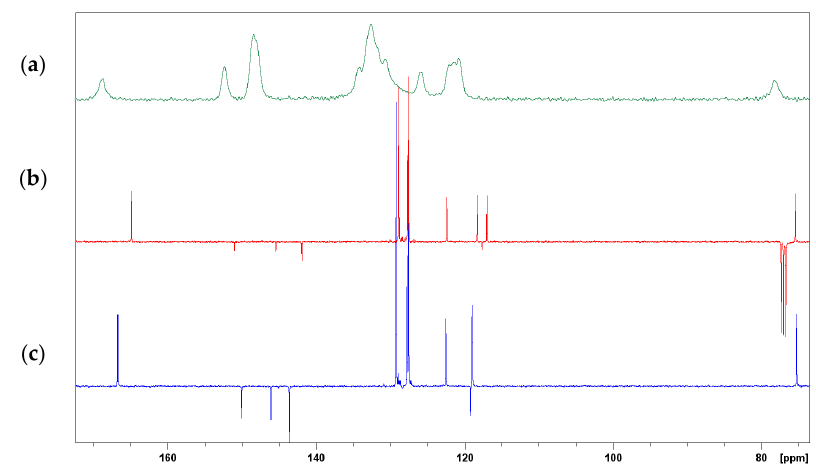
Figure D5. A comparison of solid state 13 C CP-MAS spectrum of oOHsaladpm ( a ) with solution state 13 C-DEPTq spectra in CDCl 3 ( b ) and DMSO-d 6 ( c ).